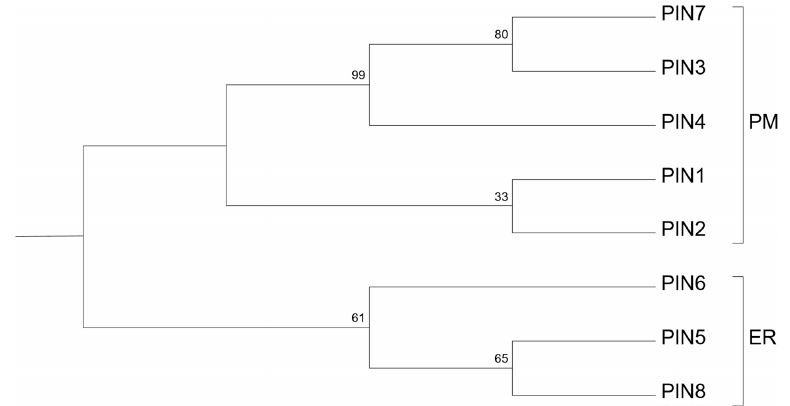
Figure 1. A ClustalW-based maximum likelihood [17] phylogenetic tree of the PIN proteins in A. thaliana , rooted with KfPIN [18]. PM: PINs present on PM, ER: PINs showing ER or dual PM and ER localization.